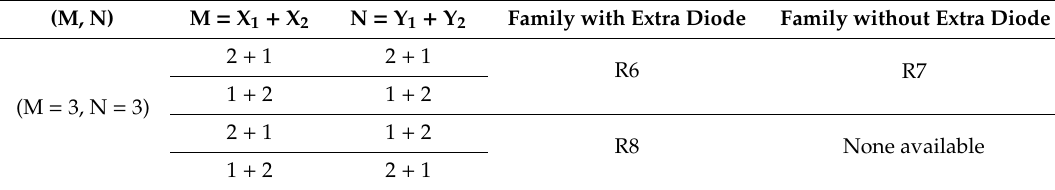
Figure 13. Four topologies derived from X 1 = 2, X 2 = 1, Y 1 = 2, and Y 2 = 1. ( a ) R6 [16,31]; ( b ) R7 (circuit one); ( c ) R7 (circuit two); ( d ) R7 (circuit three) [12]. Similarly, one topology derived from X 1 = 2, X 2 = 1, Y 1 = 1, and Y 2 = 2 is shown in Figure 14.